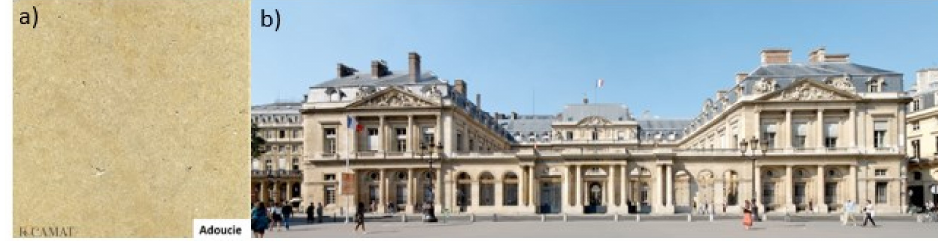
Figure 2. ( a ) Lutetian stone, ( b ) The Royal Palace of Paris,